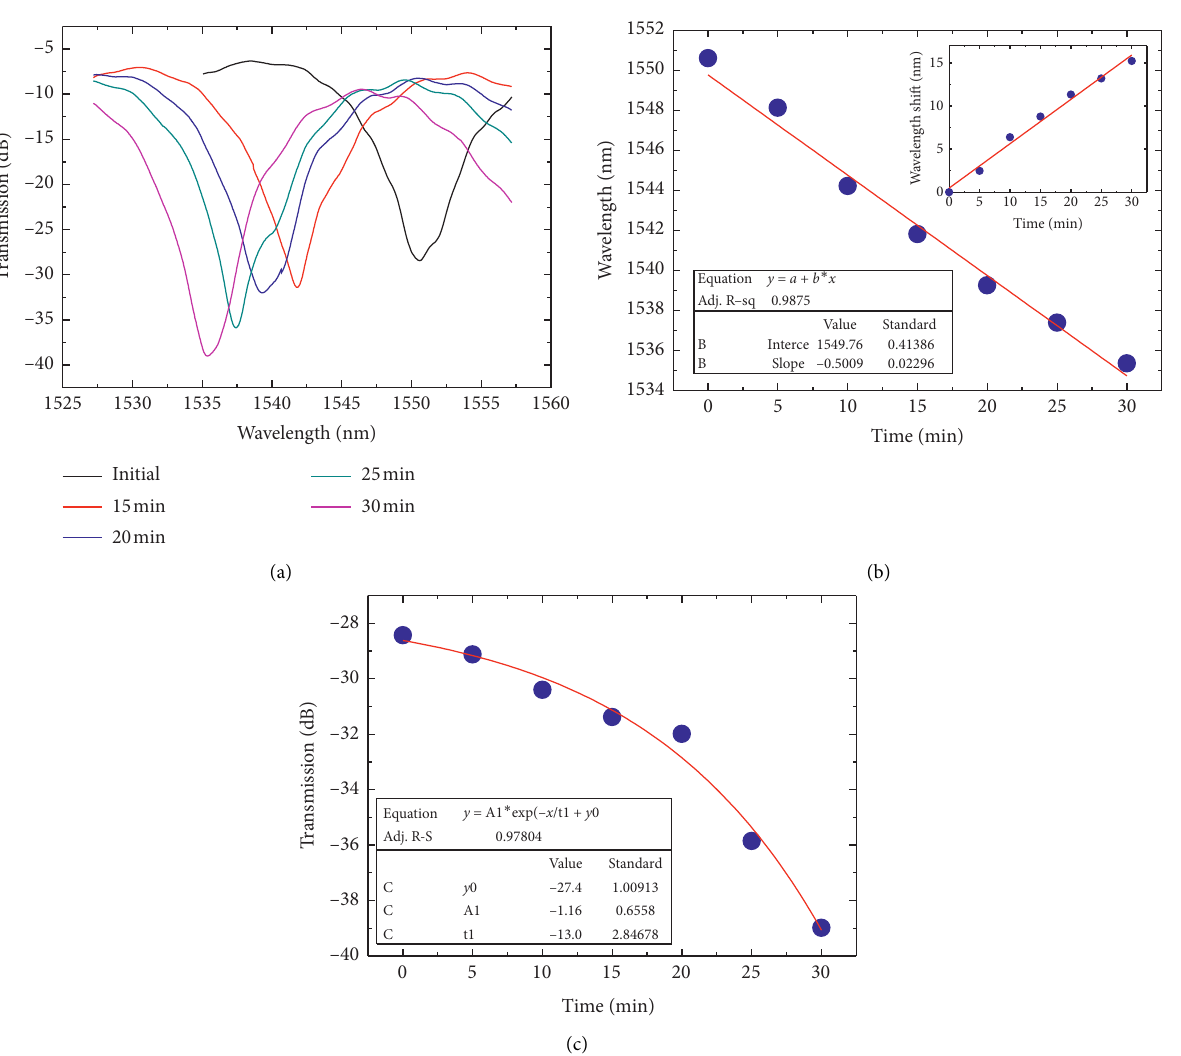
Figure 4: (a) Measured spectral responses after 4 hours, which was recorded every 5 min; the wavelength shift (b) and transmission loss (c) caused by the change of the bacterial